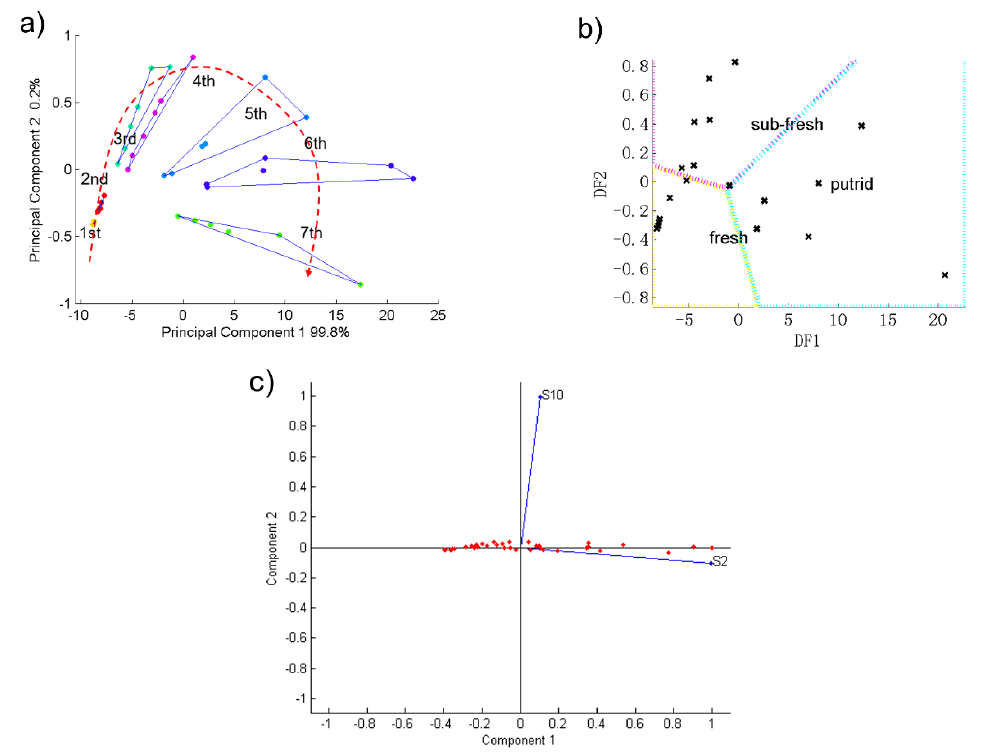
Figure 5. The results of beef samples with different storage times during 7 days: ( a ) PCA result; ( b ) DFA result and ( c ) Loading plot figure.